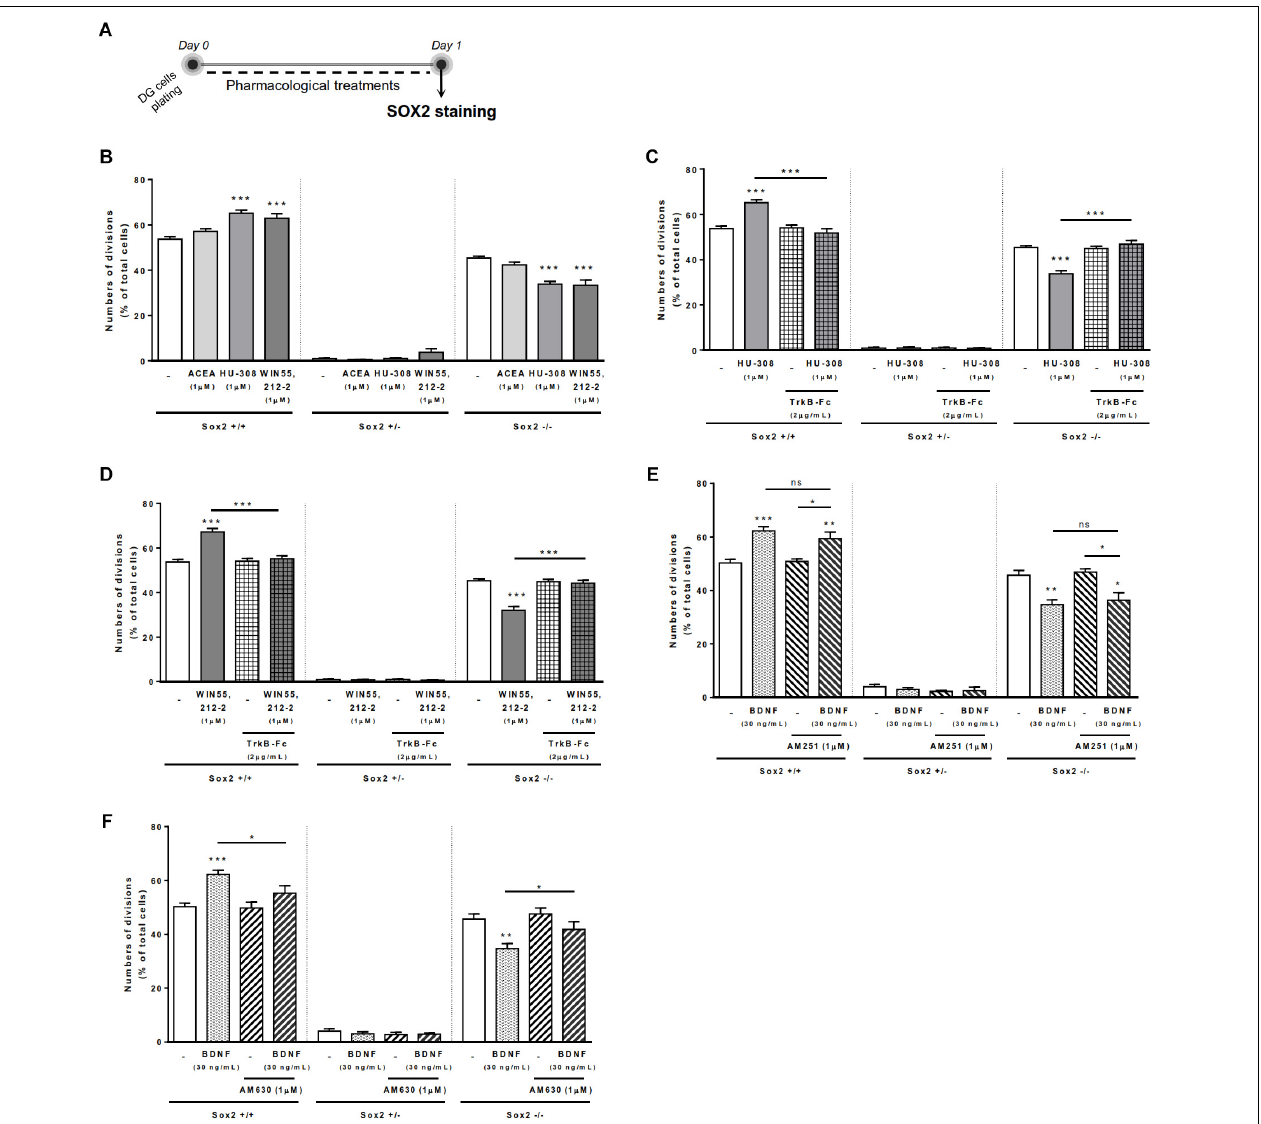
FIGURE 4 | BDNF-CB2R crosstalk regulates DG self-renewal. CB2R selective and non-selective activation increased DG self-renewal capacity, an effect abrogated by endogenous BDNF removal. Conversely, BDNF-mediated increase in DG self-renewal was dependent on CB2R, but not CB1R, modulation. (A) Schematic representation of the experimental protocol used to study cell-fate. Day 0 represents the day of cultures where the DG cell suspension was treated with the drugs for 24 h. (B–F) Bar graphs depict the percentage of Sox2+/+, Sox2+/–, Sox2–/– cell pairs expressed as percentage of total cells per culture. Data are expressed as mean ± SEM. n = 3–7. ∗ p < 0.05, ∗∗ p < 0.01, and ∗∗∗ p < 0.001 using Dunnett’s multiple comparison test. ns,